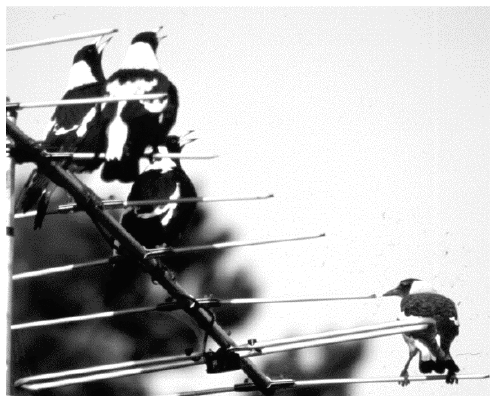
Figure 15. Group carolling with the exclusion of a juvenile (sitting apart and not vocalising) on the extreme right of the image.